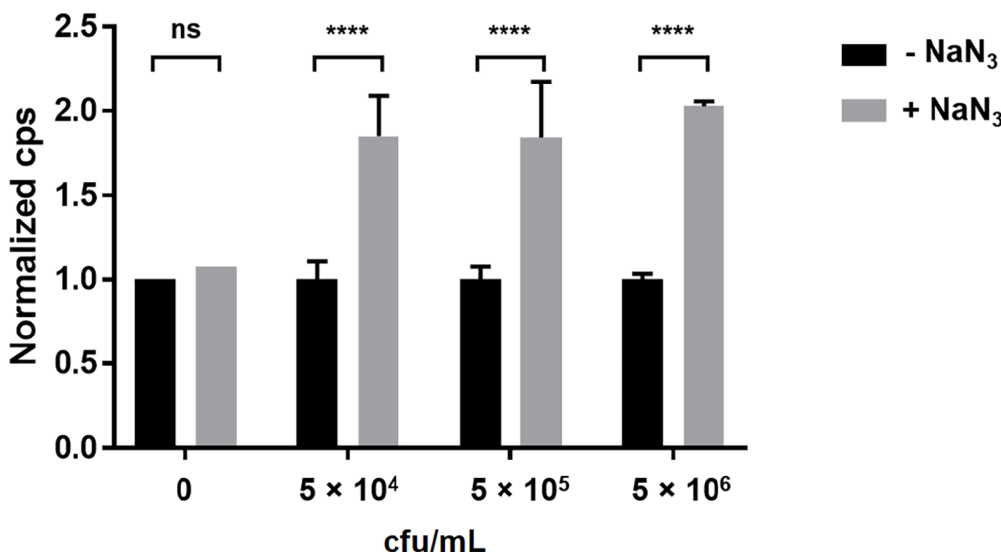
Figure 2. Effect of sodium azide (NaN 3 ) addition on bioluminescent signal intensity. Different concentrations of Listeria monocytogenes ScottA cells ranging from 5.0 × 10 4 to 5.0 × 10 6 cfu/mL were infected with 1.0 × 10 8 pfu/mL of A511:: luxAB . Bacteria were incubated with phages in 200 µL of BHI ½ in microwell plates at 24 °C for 140 min. Measurements were performed in parallel with identical samples with and without the addition of 7.6 mM NaN 3 as signal enhancer. For each bacterial concentration, bioluminescence signals have been normalized to the control sample (without NaN 3 ). Asterisks indicate significant differences between values obtained with and without NaN 3 . ****, p < 0.0001; ns, non-significant.